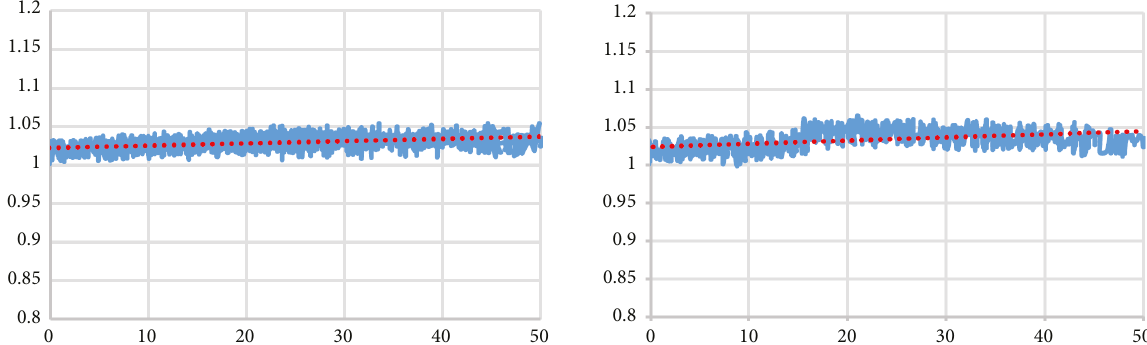
Figure 4: Dependence of the accelerometer X-axis values (1g – 9.81 m/s 2 ) upon the temperature during slow (1 ∘ C/min) heating (left) and cooling